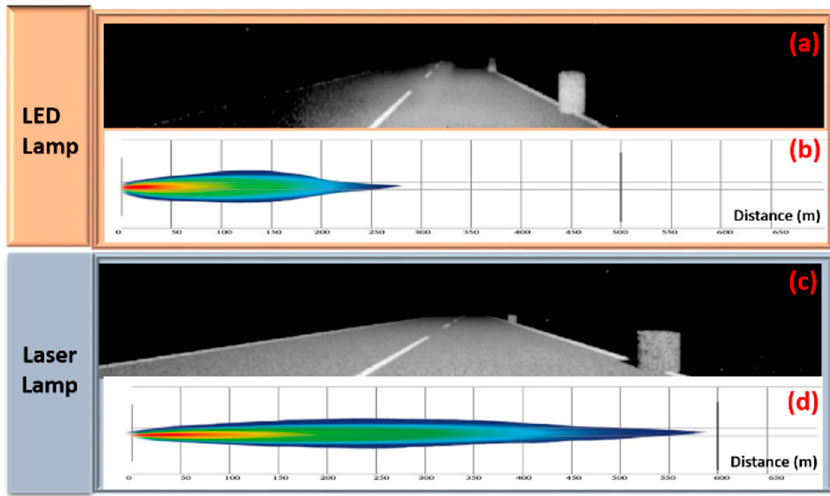
Figure 6. Street visualization with ( a ) LED headlamp and ( c ) laser headlamp and top view energy